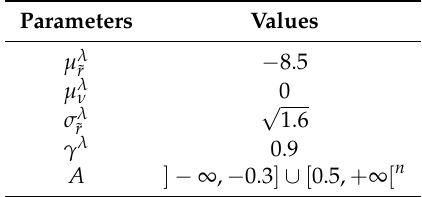
Figure 4. Data collected over time ( · ) and true temperature evolution (line) at the data collection points. Table 1. Parameter values for the selection-Gaussian initial distribution for the initial log-diffusivity